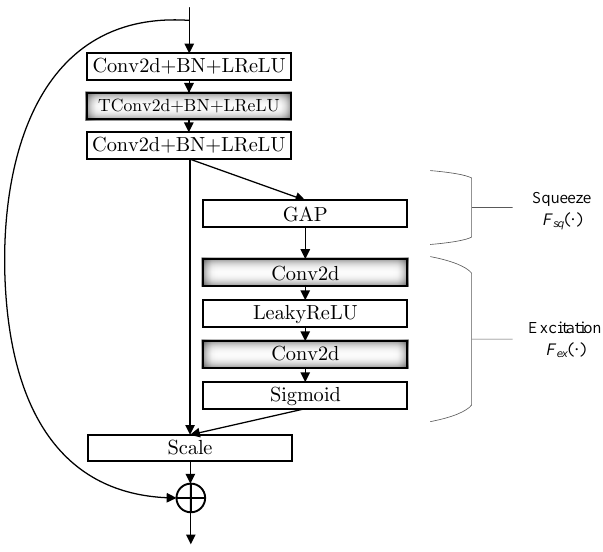
Figure 4. Decoding